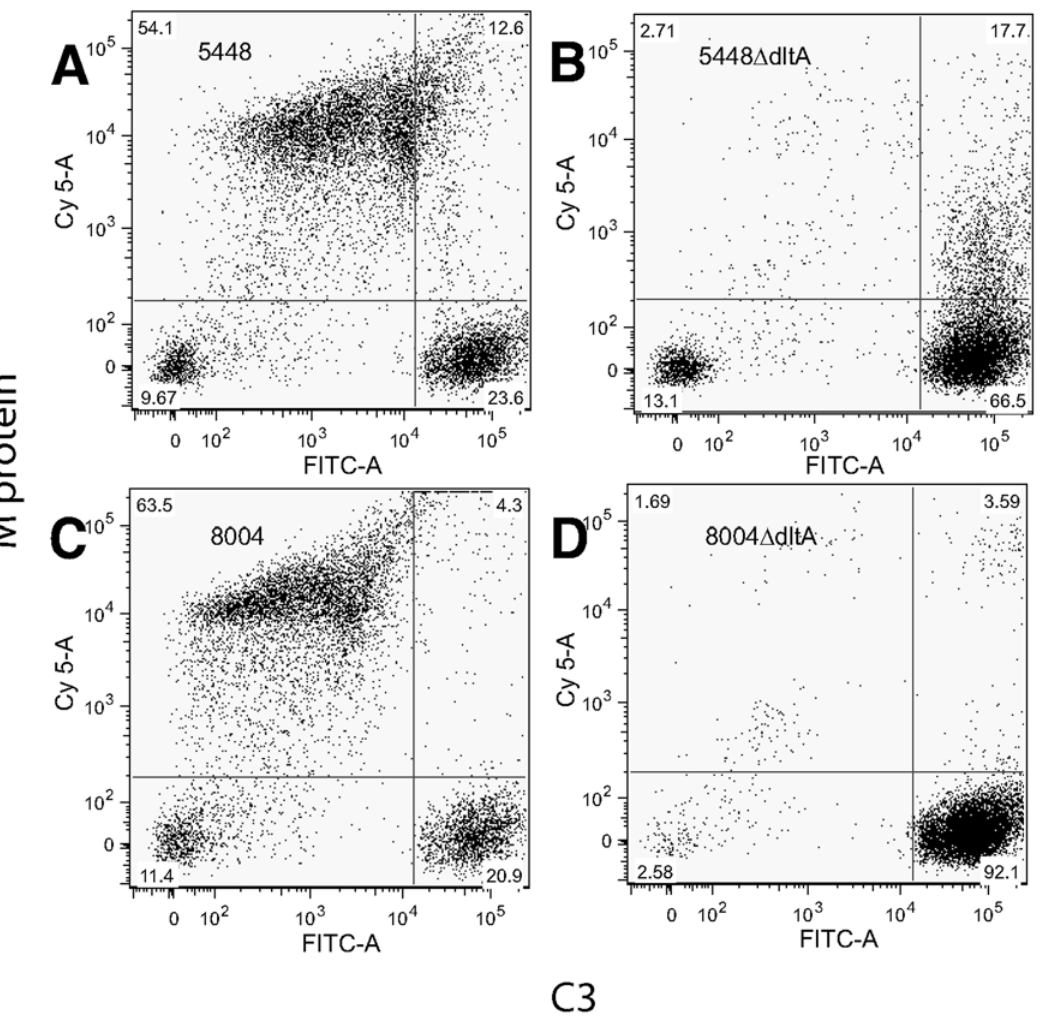
Figure 6. Comparing the relationship of complement deposition to M protein levels by flow cytometry. WT cells, 5448 (panel A) and 8004 (panel C), and their isogenic mutants, 5448 D dltA (panel B) and 8004 D dltA (panel D), were labeled with anti-C3 (FITC-A) and anti-M1 (Cy5-A). Numbers are given representing the % of cells in each gated area.